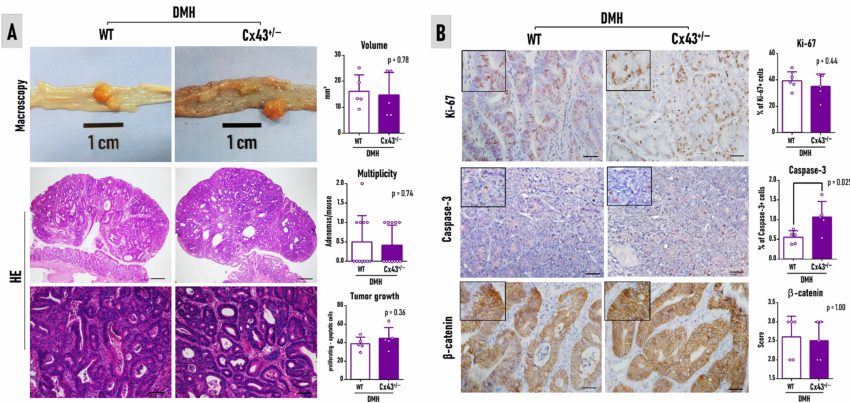
Figure 5. Implications of Cx43 +/ − on colorectal adenoma (CRA) development during 1,2- dimethylhydrazine (DMH)-induced colon carcinogenesis in C57BL/6J mice at week 37. ( A ) Represen- tative macroscopic (top) and microscopic overview (HE-stained sections, middle (scale bar: 100 µ m) and bottom (scale bar: 50 µ m)), volume, multiplicity, and tumor growth data of DMH-induced CRAs in both genotypes. ( B ) Representative microscopic overview (details, scale bar: 20 µ m) and semiquan- titative analysis of Ki-67, cleaved caspase-3, and β -catenin immunostaining of DMH-induced CRAs in both genotypes. WT: wild-type. Data were presented as median + interquartile range ( β -catenin) or mean + standard deviation (rest) and data points. Data were analyzed by the Mann–Whitney